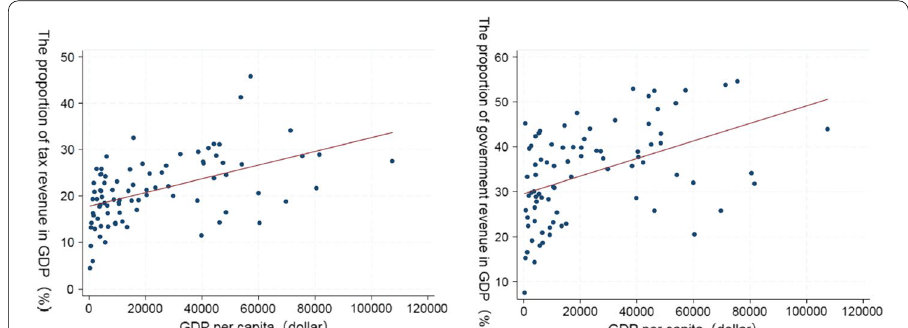
Fig. 6 The relationship between macro tax bearing and the economic development level of major countries in the World, 2017. Data source: World Bank and OECD. Note : The tax revenue in the left figure includes taxes on income, profits, capital gains, property, goods, services, and so on. Social contributions are excluded. The government revenue in the right figure includes tax revenue, social contributions, grants and other revenue. The major countries refer to countries with macro tax bearing data in the database, excluding countries with missing